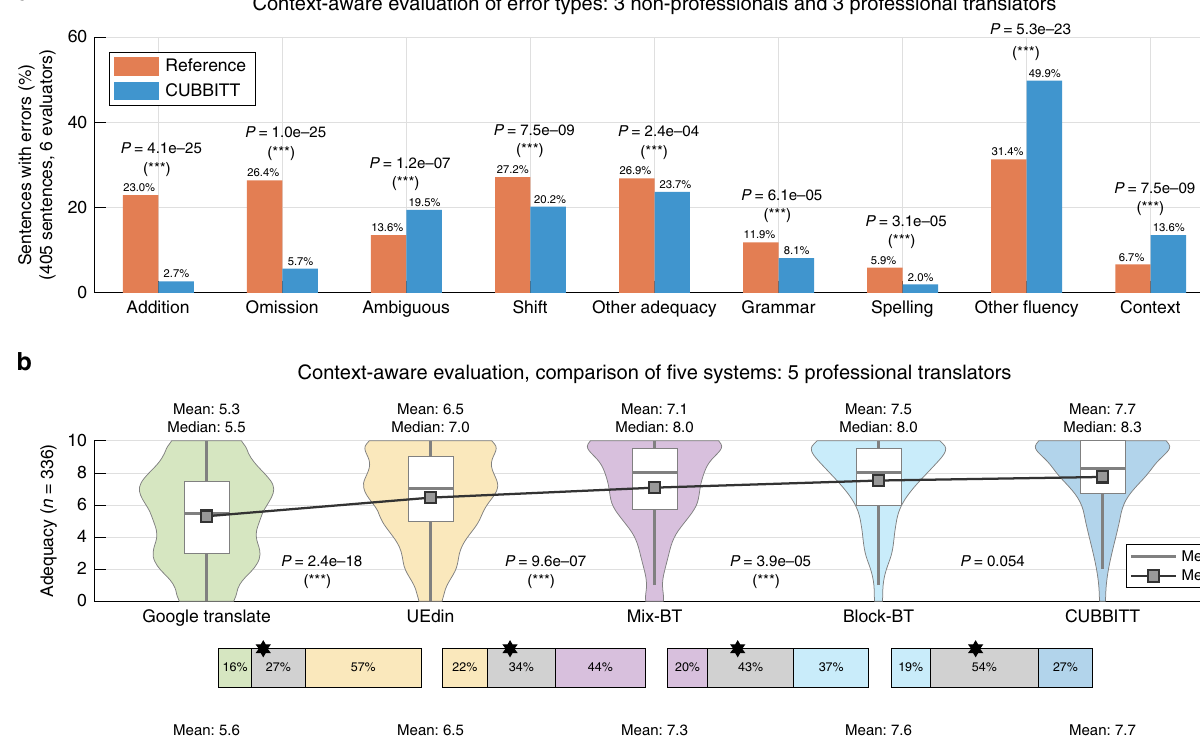
compared to 5.2% in reference, P = 1.2e-10, sign test, Fig. 4a),